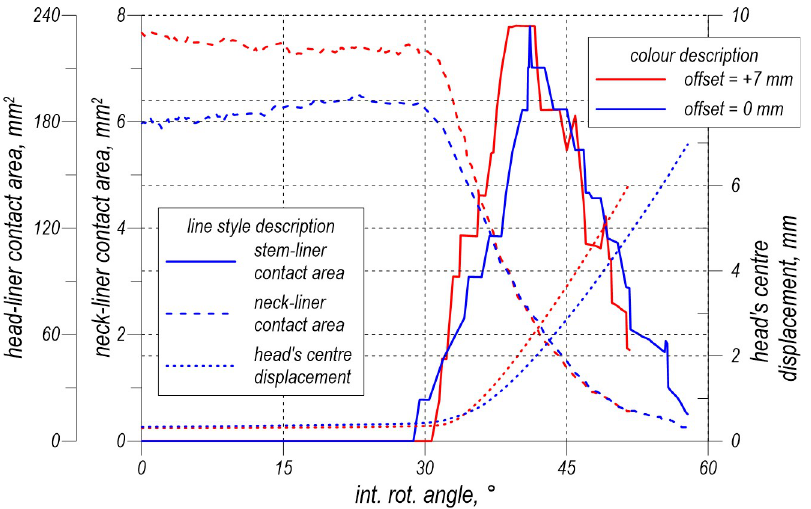
Fig 10. Analysis of the contact area and head centre